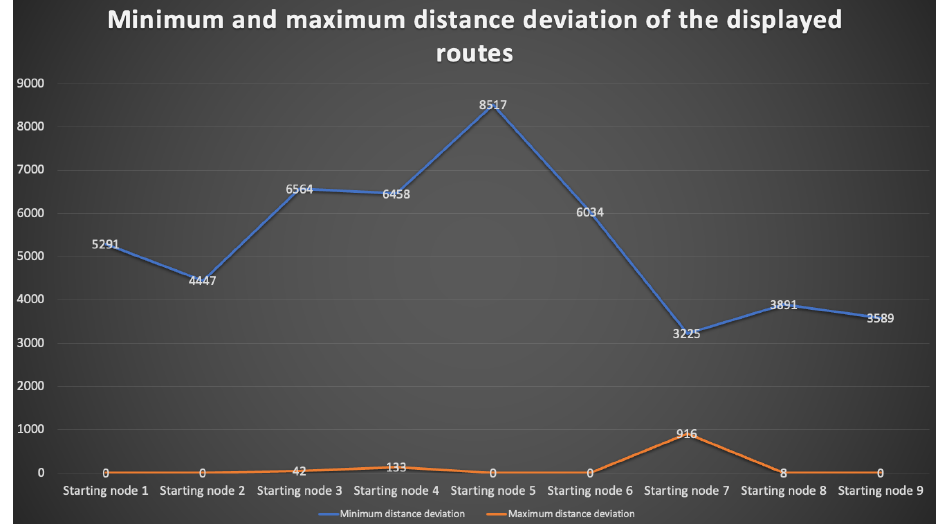
Figure 4. Minimum and maximum time deviation of the displayed